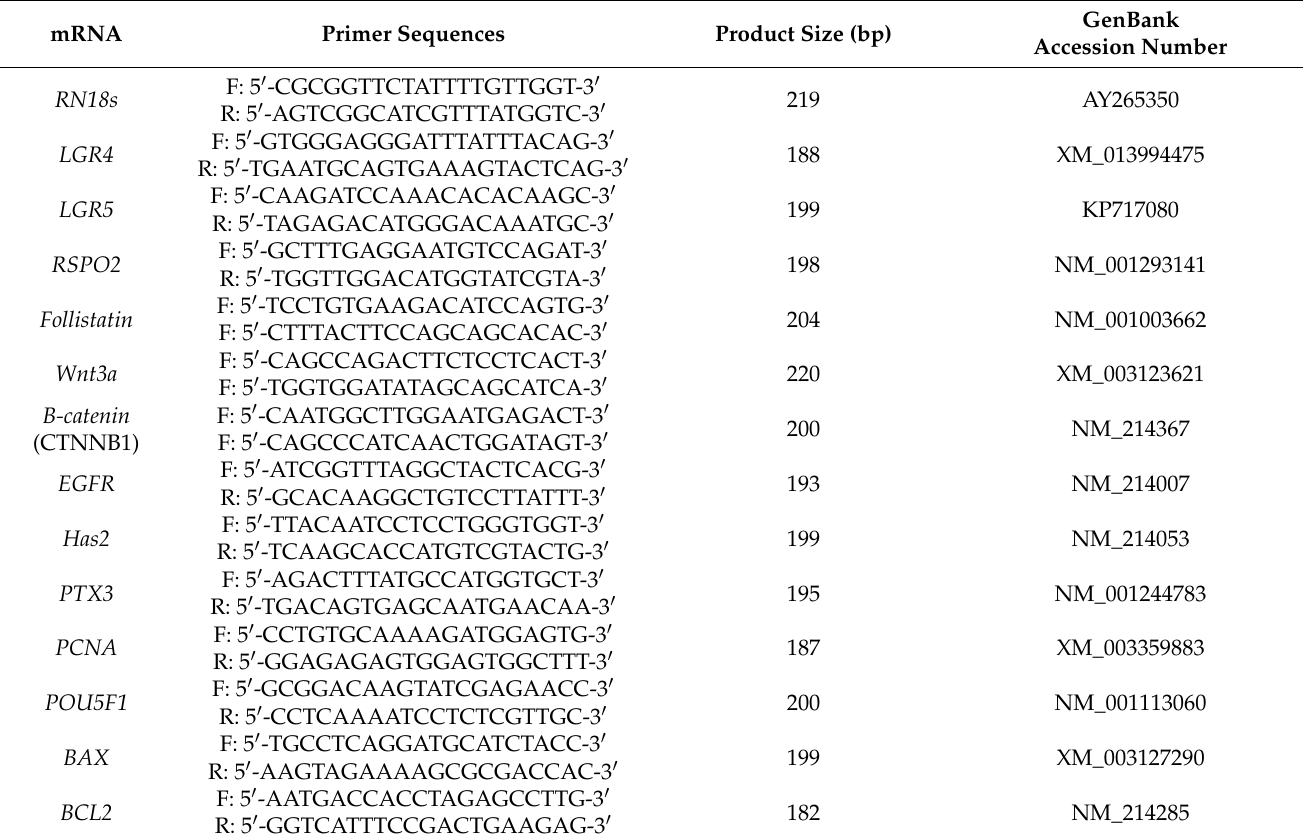
Table 2. Primer sequences for gene expression